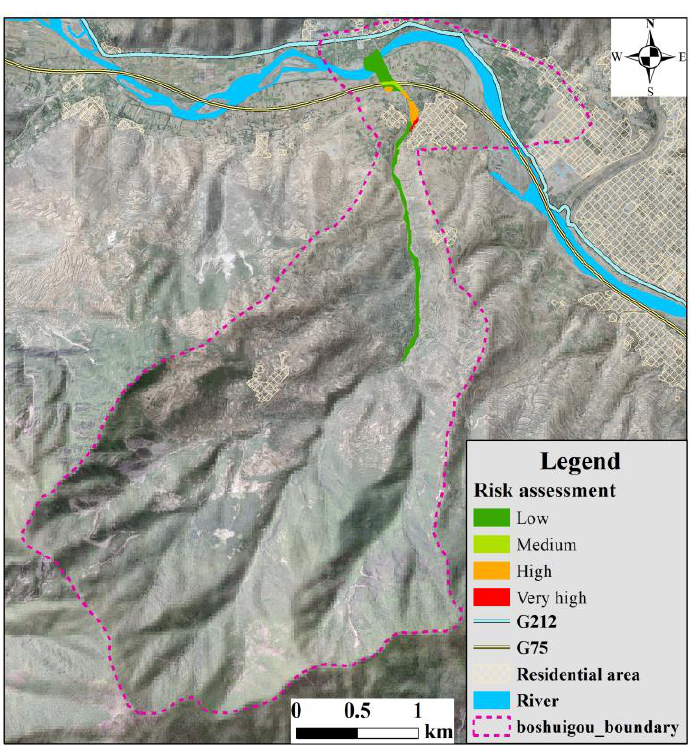
Figure 11. Risk assessment and zonation of the Boshuigou debris flow.